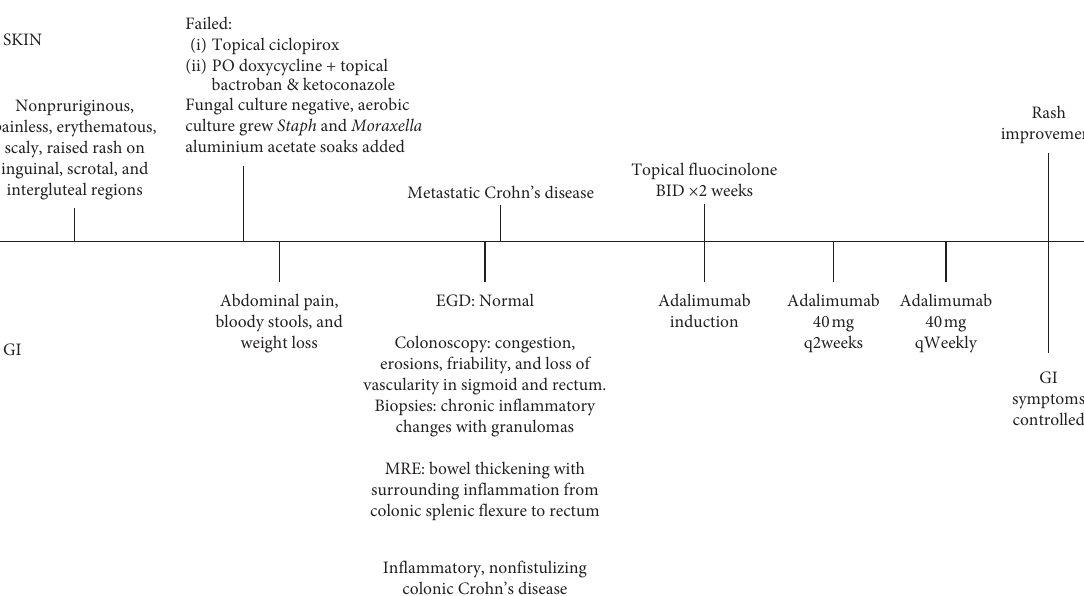
Figure 3: Timeline depicting the series of events occurring from the onset of the rash to its resolution following appropriate